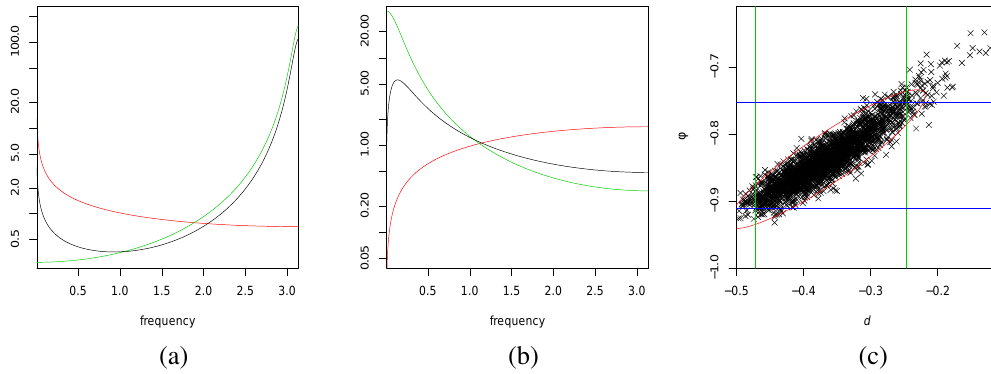
Figure 7. Spectra for processes in Fig. 6. Green line is relevant ARMA(1,0) process, red line is relevant ARFIMA(0, d ,0) process, black line is ARFIMA(1, d ,0) process: (a) (1 + 0.92 B )(1 − B ) 0 . 25 X t = ε t ; (b) (1 − 0.83 B )(1 − B ) − 0 . 35 X t = ε t . (c) Shows posterior samples of ( d , φ ) from series considered in (b) with credibility sets: red is 95% credibility set for ( d , φ ), green is 95% credibility interval for d , blue is 95% credibility interval for φ .